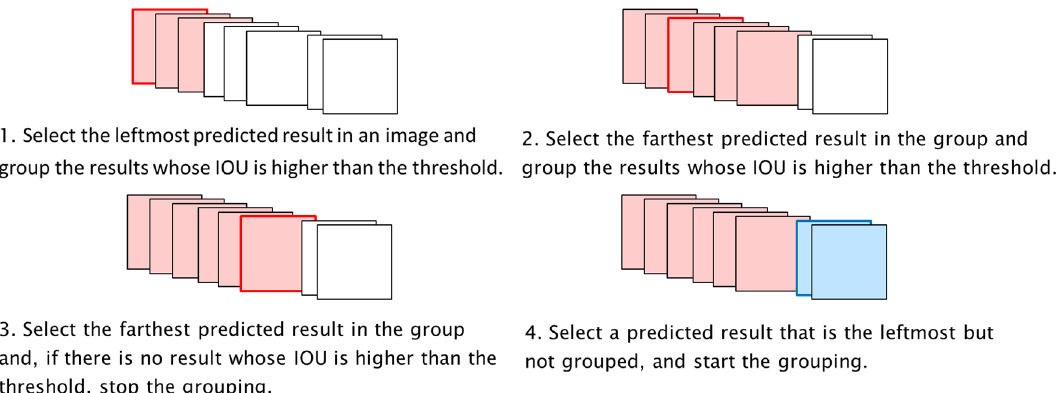
Figure 7. Grouping of adjacent predicted results.